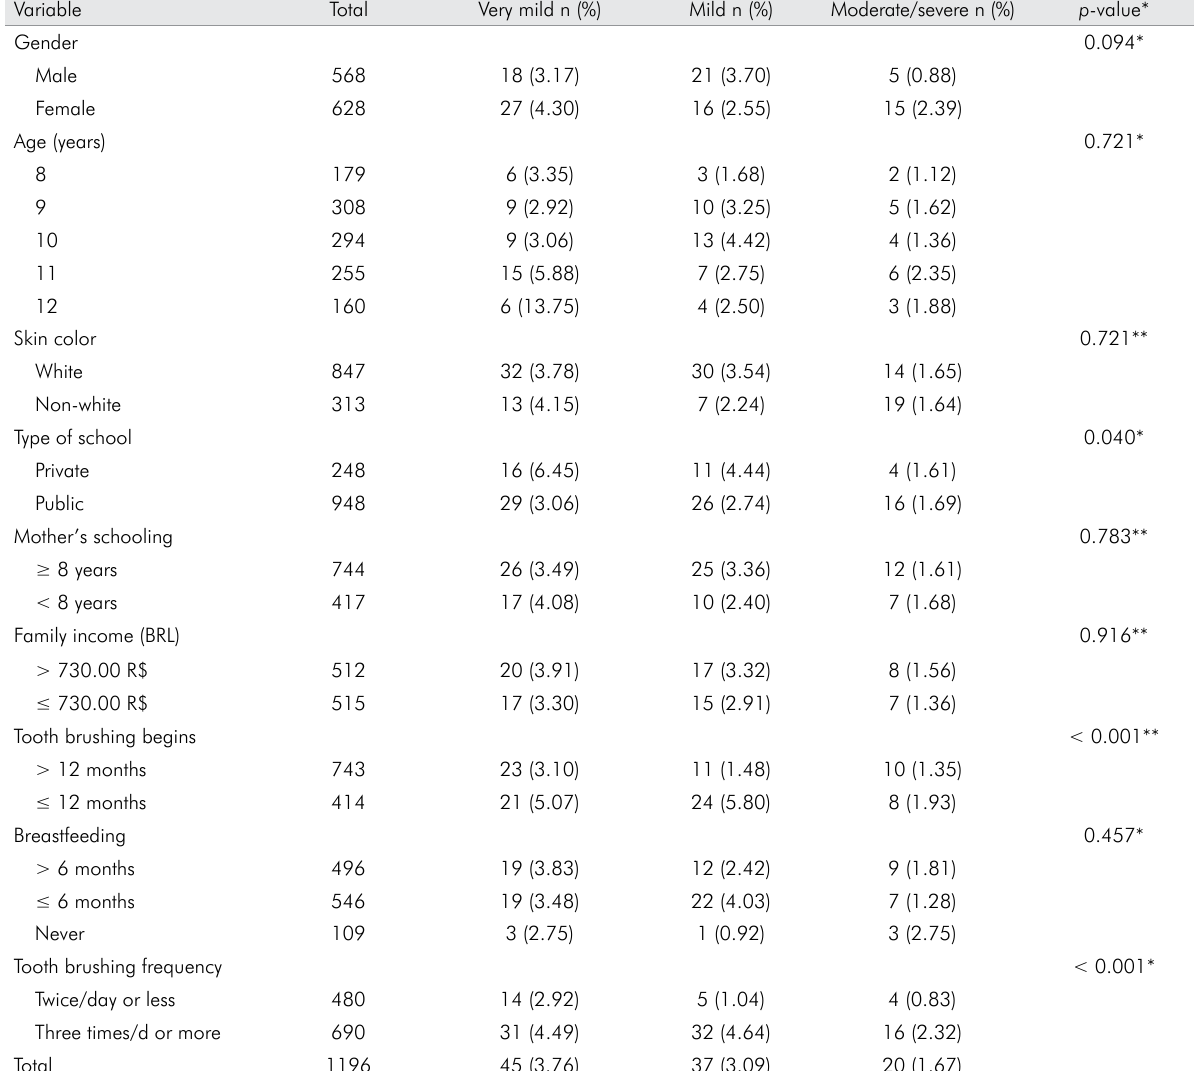
Table 1. Sample distribution according to fluorosis severity among 8- to 12-year-old children and independent variables. Pelo- tas/2010 (n =